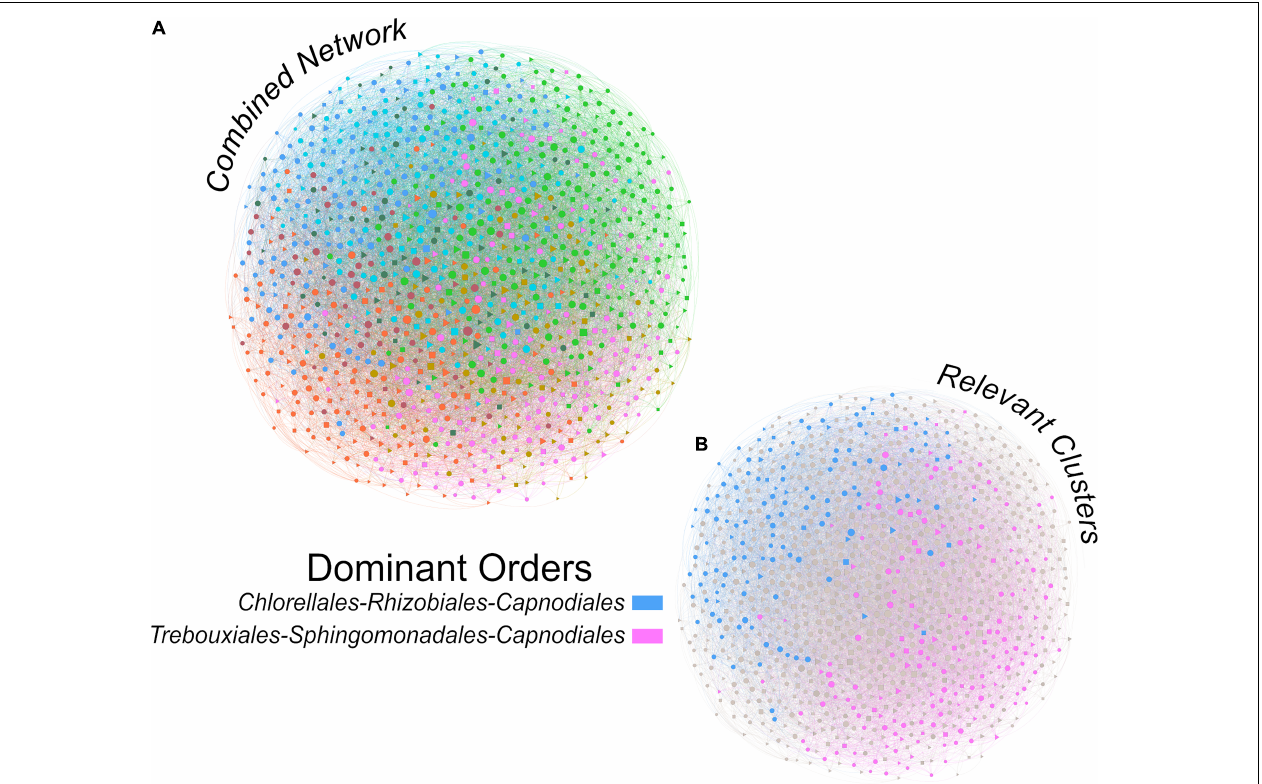
FIGURE 4 | Inter-group ASV interaction network integrating algal, bacterial and fungal taxa for a description of the interactions within the complete bark microbiome (A) . The two colored modules (B) are the two most abundant modules of the whole dataset, accounting for 29% (pink) and 26% (blue) of the total reads. The size of the nodes is proportional to the value of betweenness centrality (based on Brandes (2001)) and colors correspond to modules (Blondel et al.,